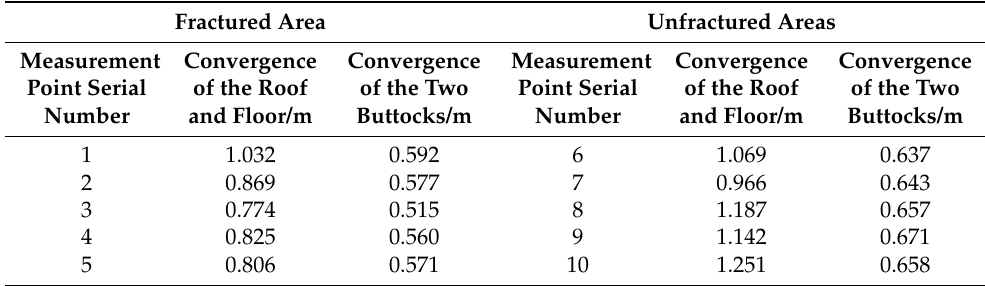
Table 5. Measurement data of the convergence of roof, floor, and two buttocks of the entry. Fractured Area Unfractured Areas